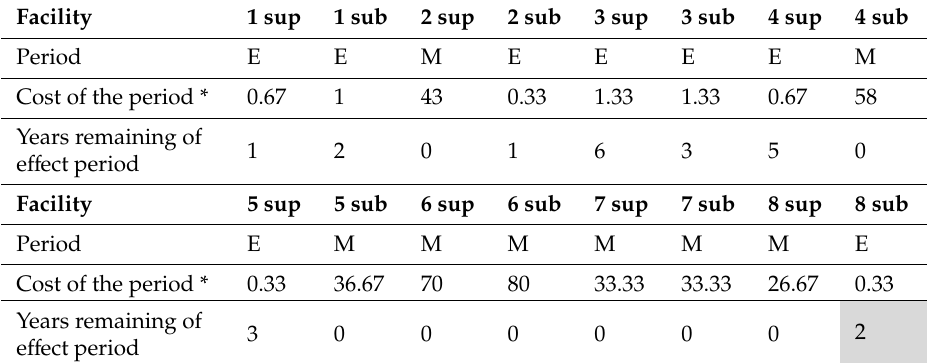
Table 14. Current status impact of budget ceiling (from USD 420 thousand to USD 419.67 thousand).